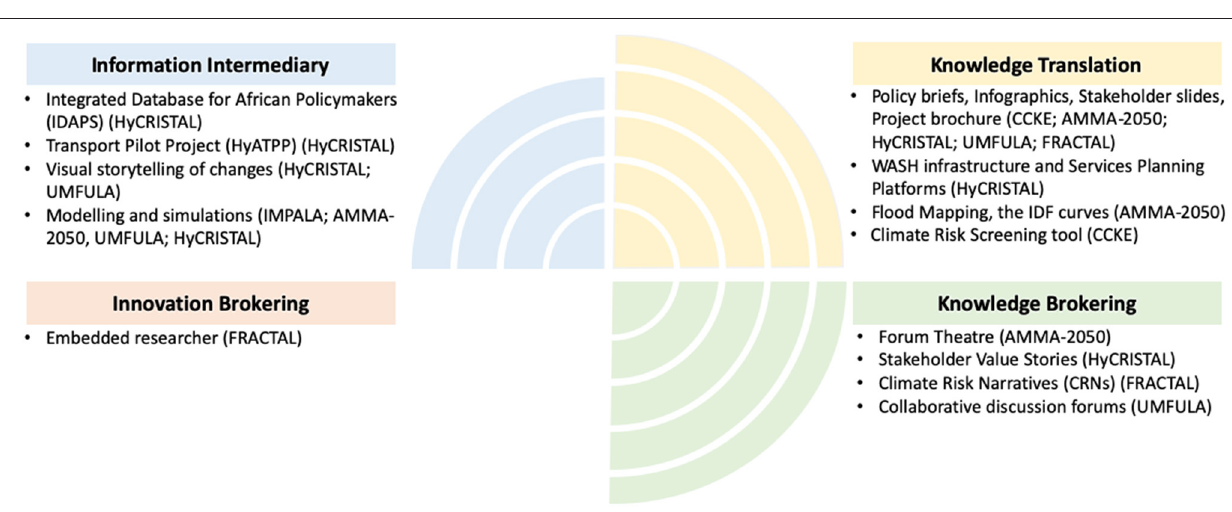
FIGURE 3 | Categorization of knowledge mobilization tools and approaches used in